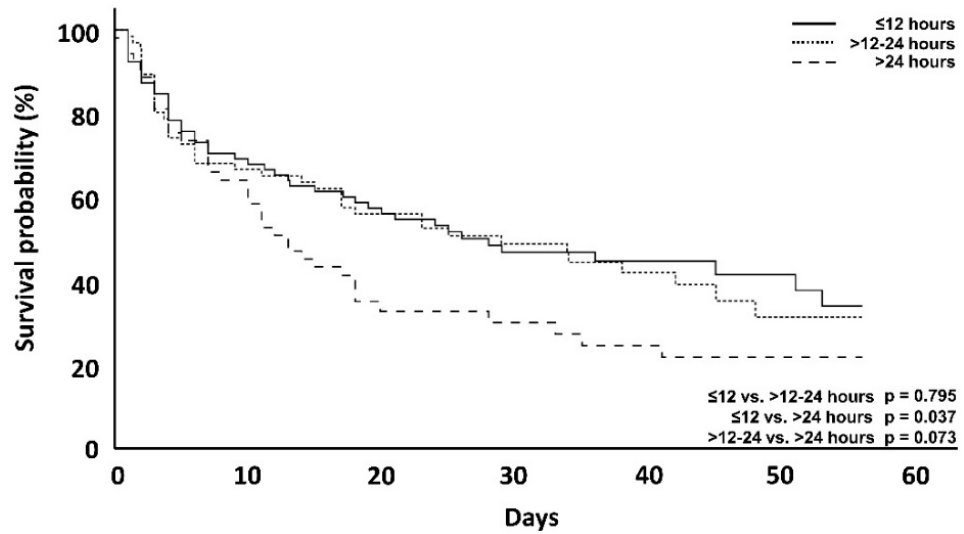
Figure 6. Kaplan–Meyer survival analysis of CytoSorb treated patients at day 56 with regard to different delay groups. The p -value is via log-rank test. * = Statistically significant using Bonferroni-adjusted alpha critical value = 0.017 (no such cases).